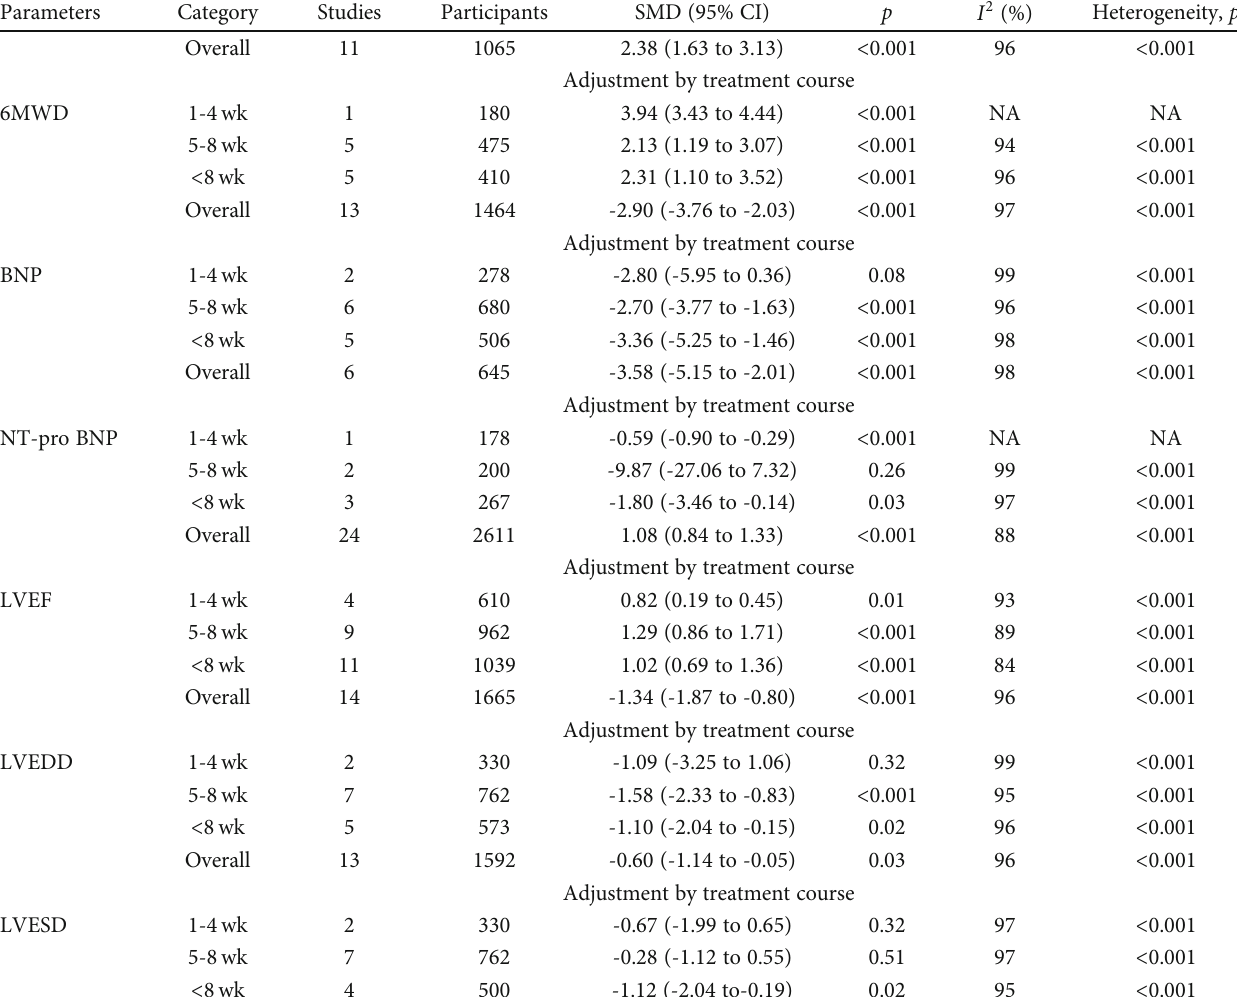
Table 1: Summarized results of the meta-analysis in high-quality